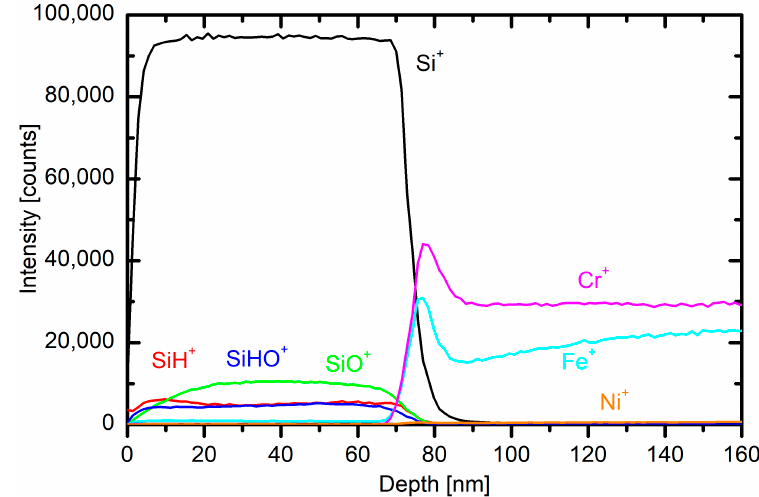
Figure 9. A typical secondary ion mass spectrometry (SIMS) depth profile of the polydimethylsiloxane (PDMSO)-like coating where only the most intense mass peaks are presented.